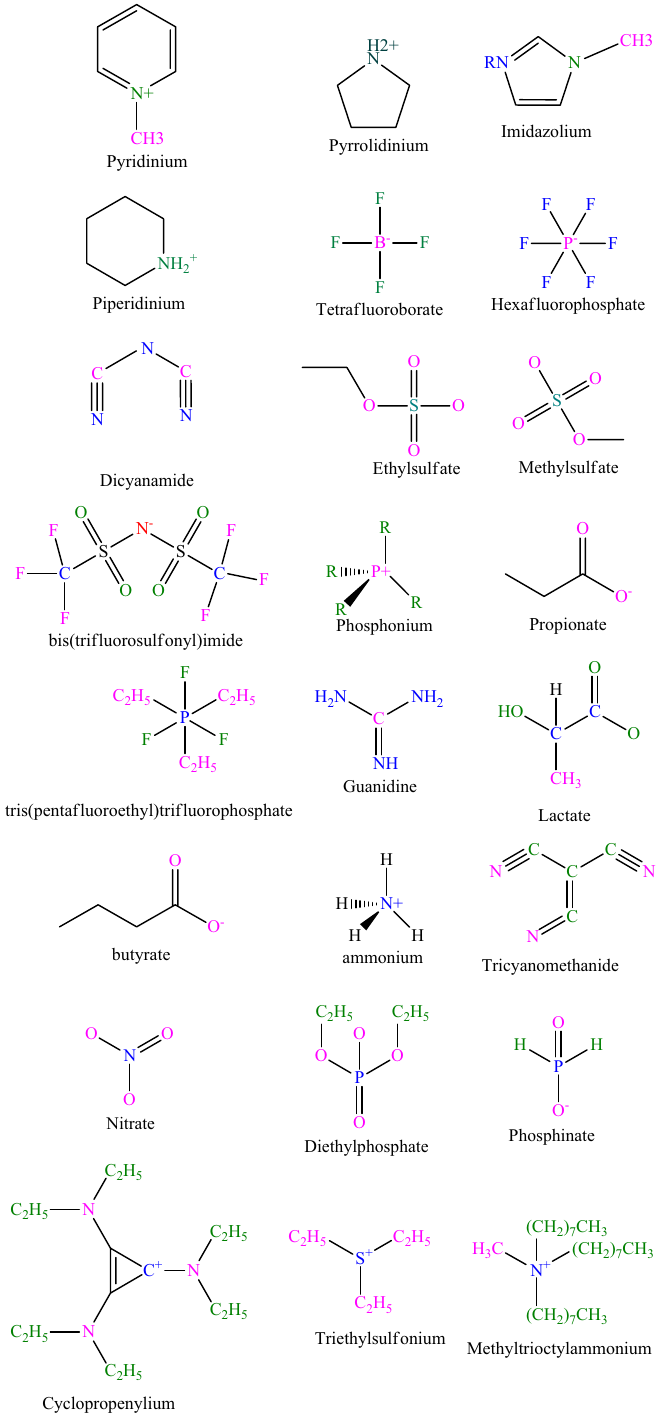
Figure 1. Chemical structure of some of anions and cations studied in this